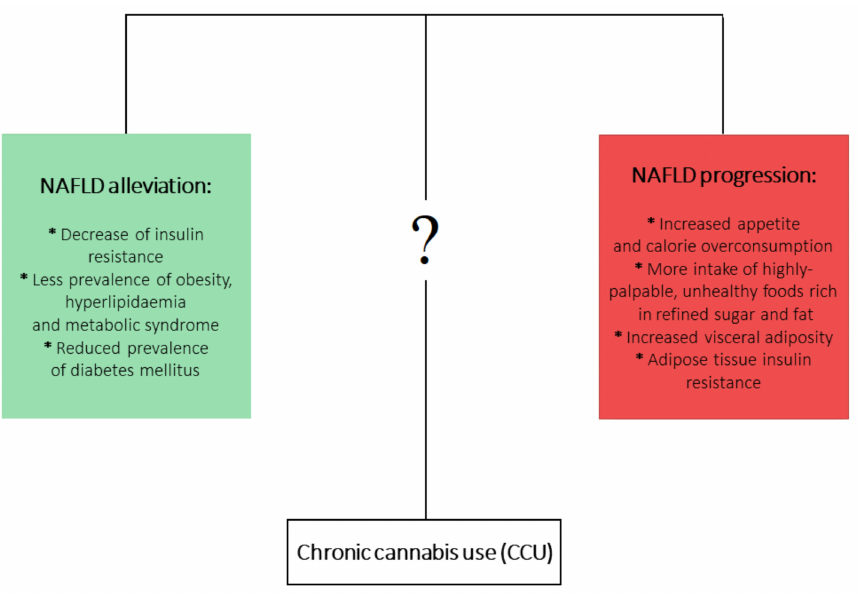
Figure 1. The opposite metabolic effects of chronic Cannabis use